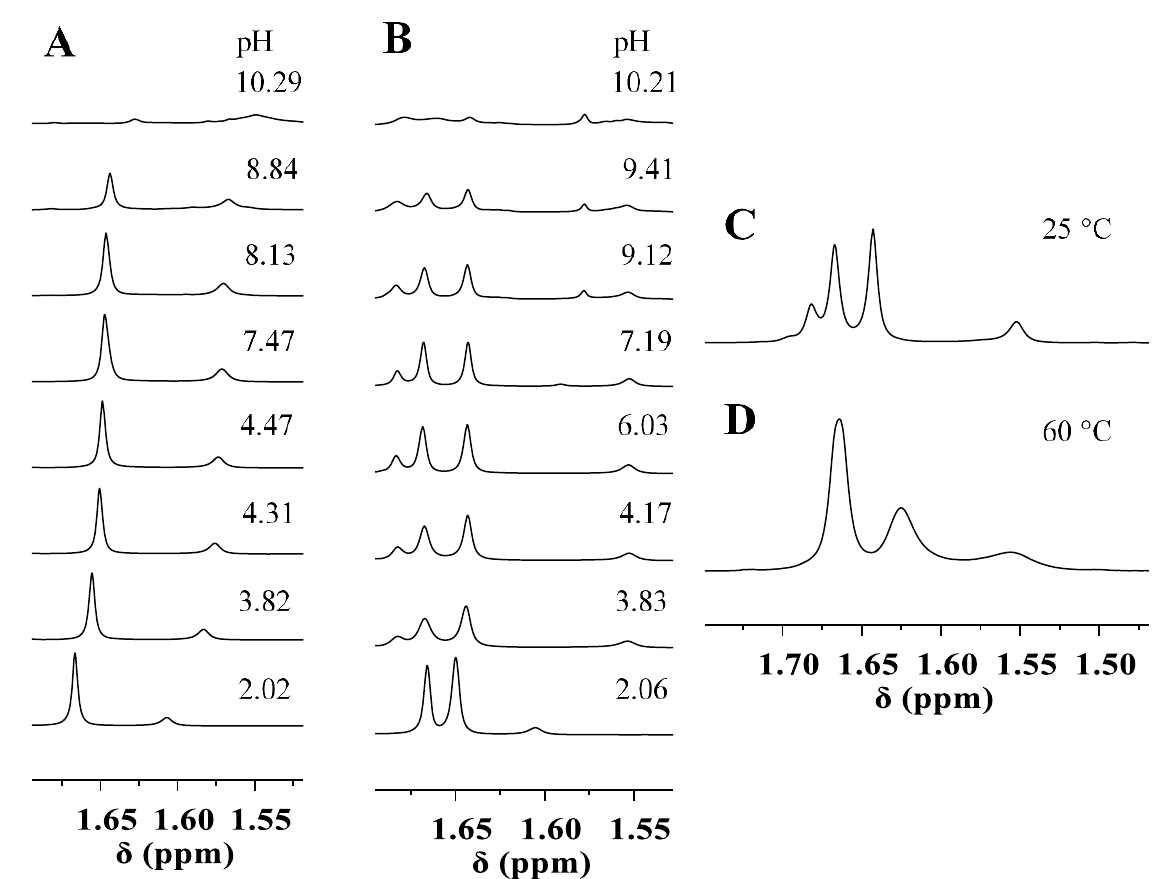
Figure 11. pH-dependence of the NMR signals belonging to the Cp* protons at 0.93:1 ( A ) and 2:1 ( B ) metal-ion-to-ligand- ratios in the [(η 5 -Cp*)Rh] 2+ –L5 system (c L5 = 5 mM). NMR signals of the Cp* protons at 2:1 ratio in the [(η 5 -Cp*)Rh] 2+ –L5 system at 25 °C ( C ) and 60 °C ( D ), pH = 4.35.